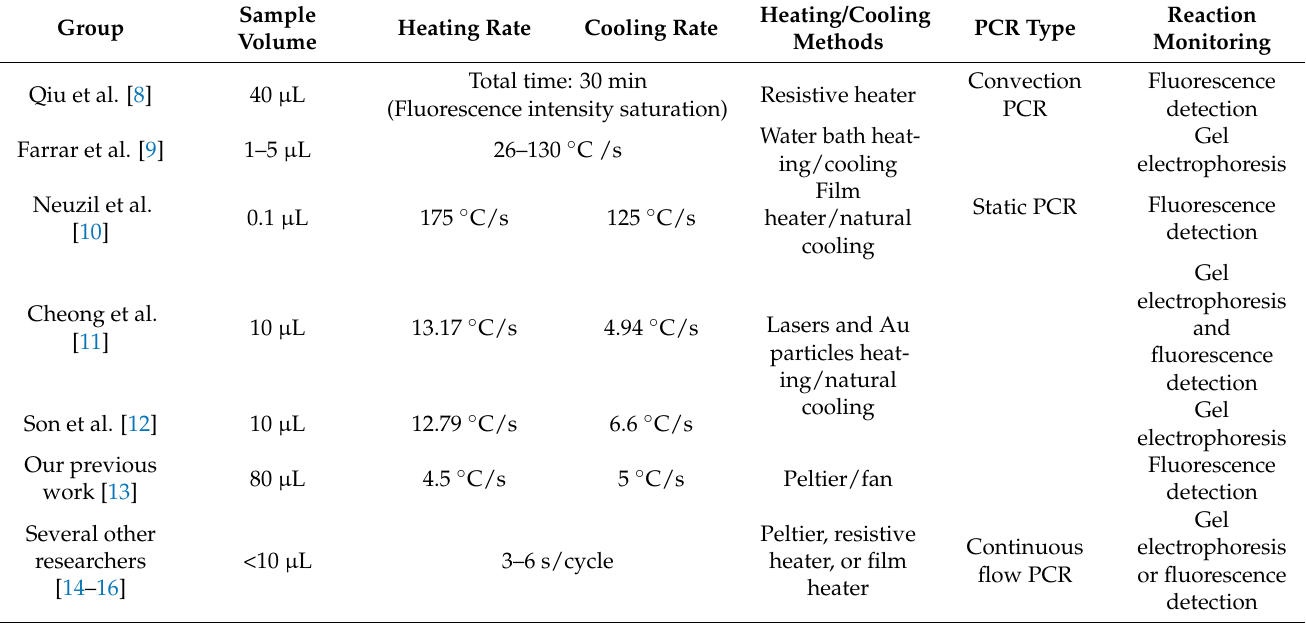
Table 1. Comparison of rapid PCR